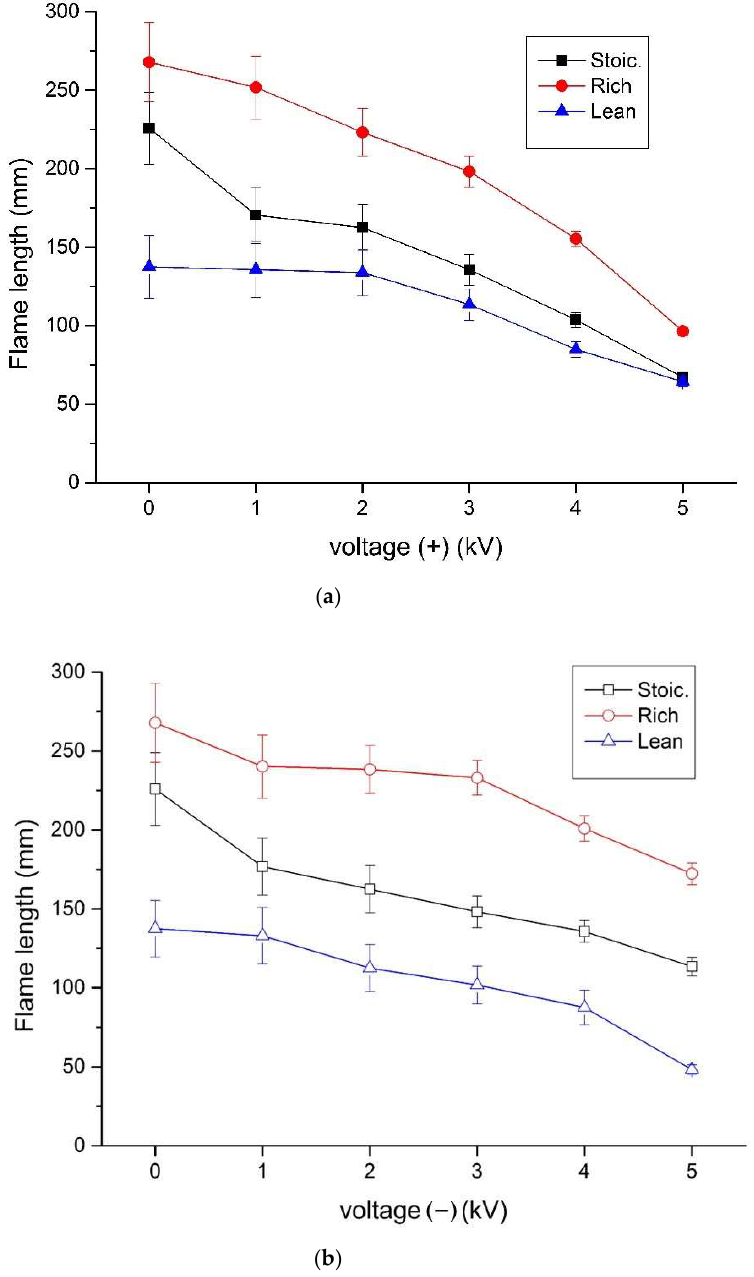
Figure 7. Flame length by electric field: ( a ) with positive voltage; ( b ) with negative voltage.